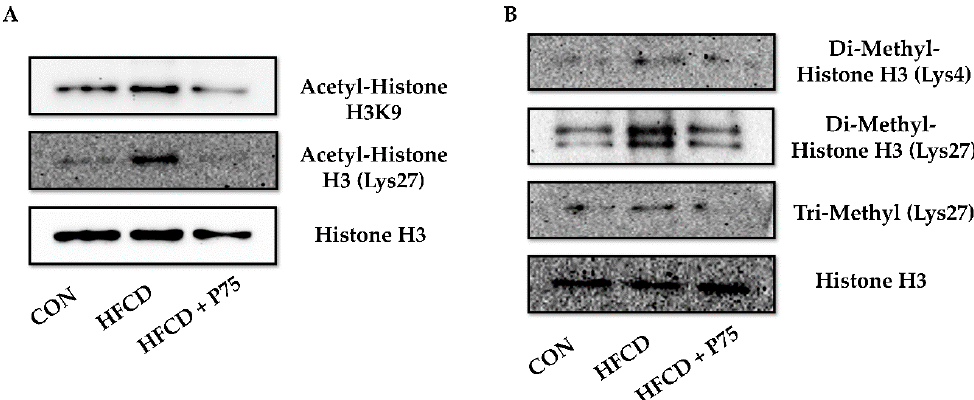
Figure 6. PEITC regulates histone modification in the livers of HFCD-fed mice: ( A ) Immunoblotting was used to measure the levels of H3K9 and H3K27 acetylation; ( B ) Immunoblotting was used to measure the levels of H3K4 dimethylation and H3K27 di- / trimethylation, and equal loading of protein was ensured by stripping the immunoblot and reprobing it for histone H3. CON: AIN-93G diet, HFCD: 60% calories from fat + 1% cholesterol, HFCD + G: HFCD + 3 mg / kg / day GA, HFCD + P30: HFCD + 30 mg / kg / day PEITC, HFCD + P75: HFCD + 75 mg / kg / day PEITC.